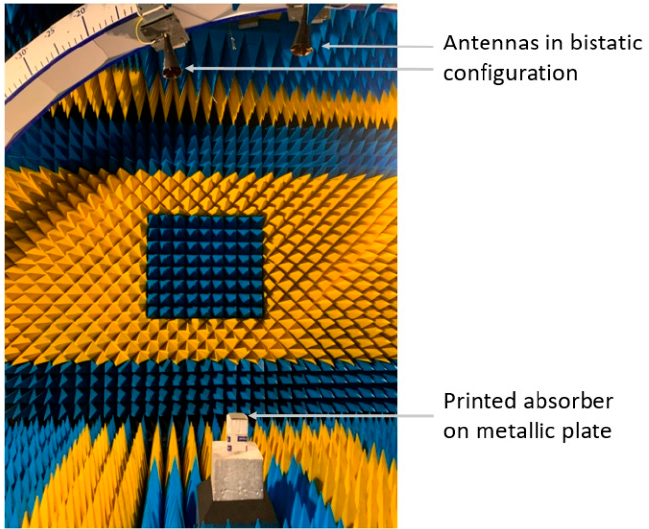
Figure 4. Photography of the setup process of the reflectivity measurement of the absorber in the anechoic chamber.